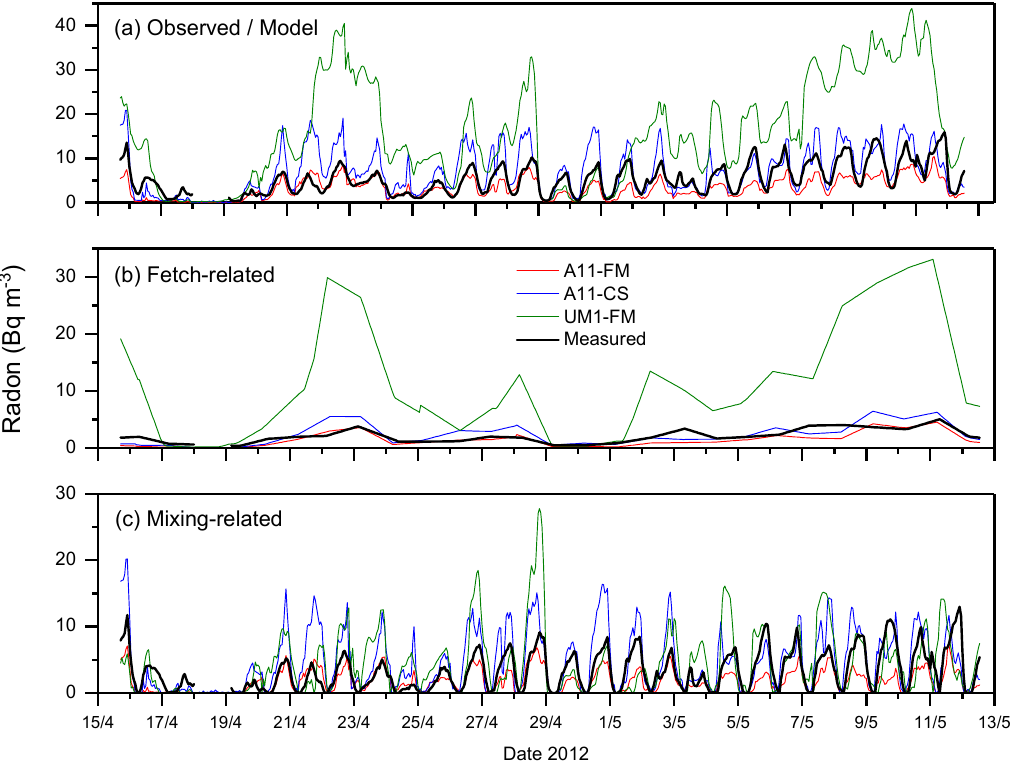
Figure 11. ( a ) Simulated and observed hourly radon time series at Westmead, ( b ) fetch-related component of the simulated & observed concentrations, and ( c ) mixing-related component of simulated & observed radon concentrations.